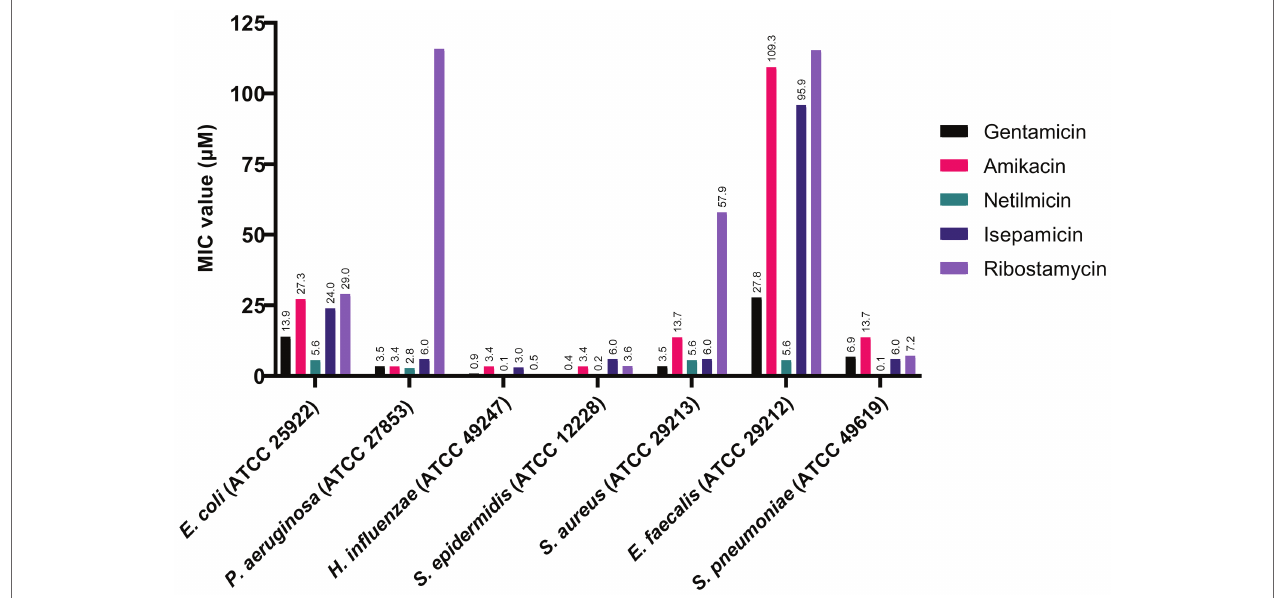
FIGURE 2 | Antibacterial activity of aminoglycosides against selected Gram-positive and Gram-negative